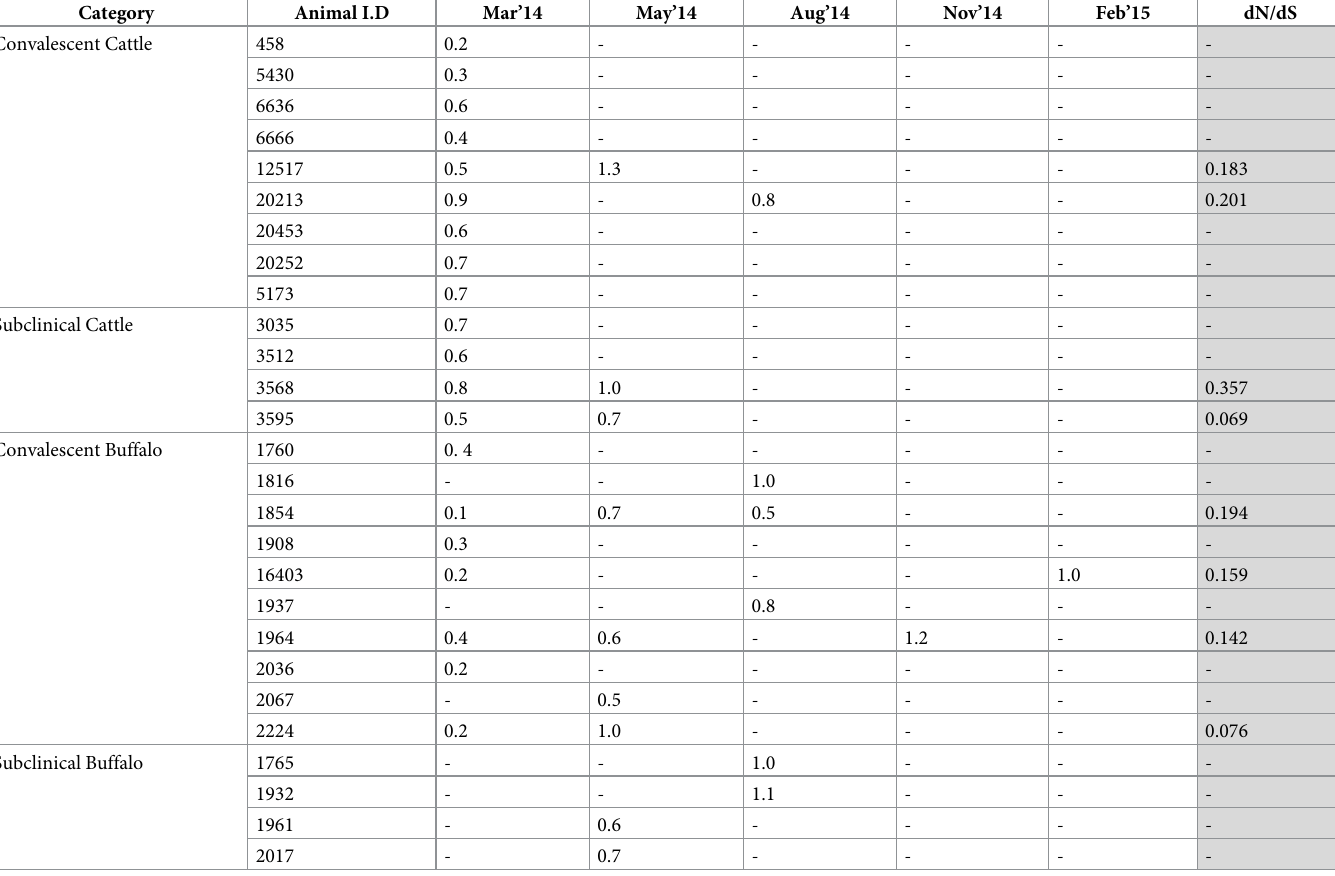
Table 1. Nucleotide divergence (%) in the capsid coding region of virus isolates from carrier animals compared to the virus isolate collected during the acute phase of the outbreak in January 2014. The dN/dS ratio is reported for animals from which multiple virus isolates were recovered.